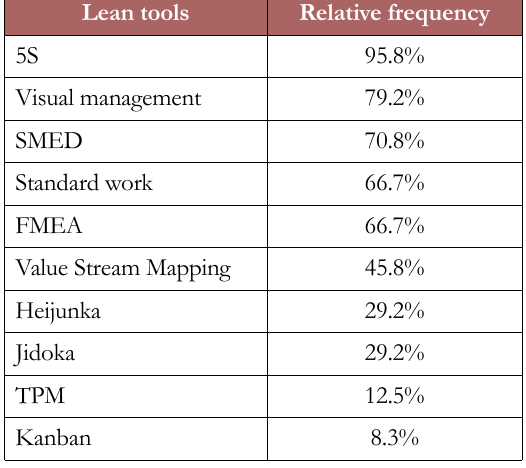
Table 3. Lean tools